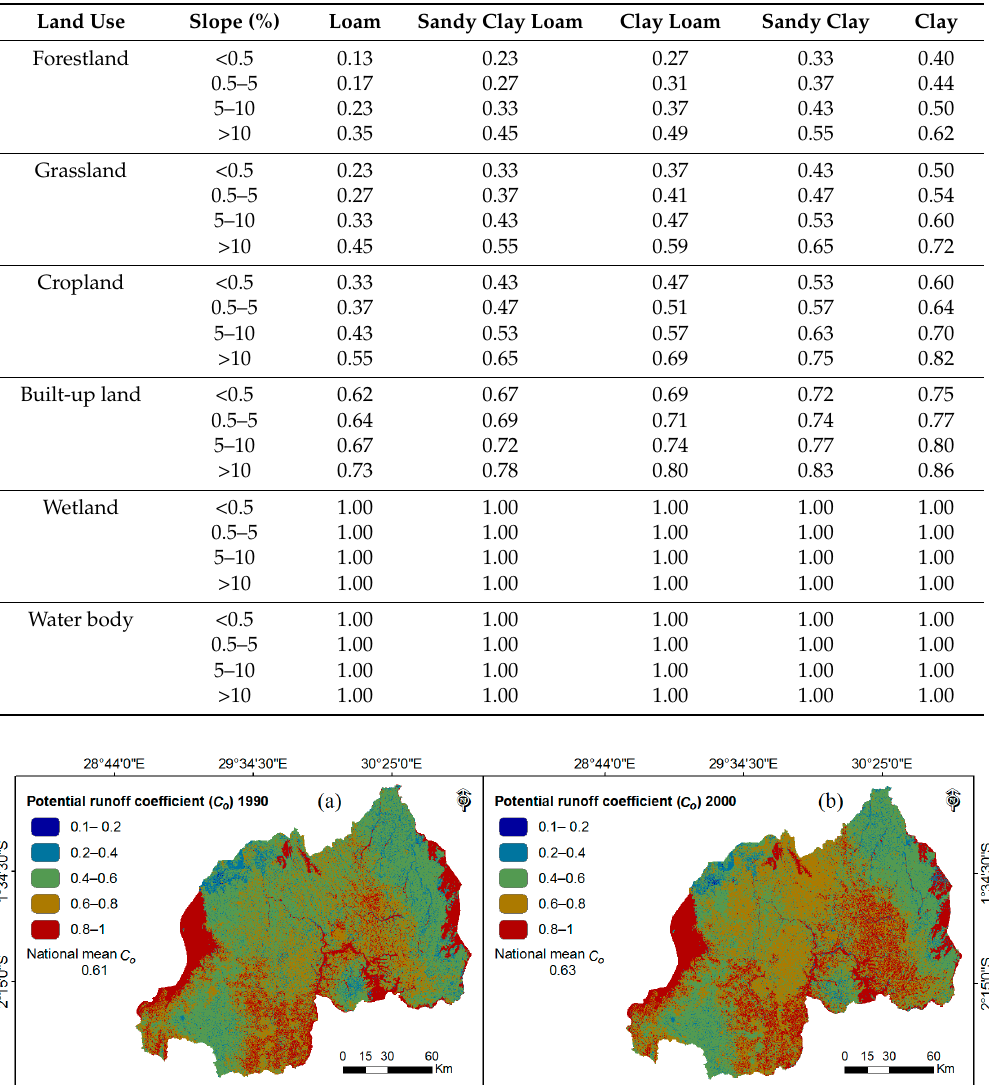
Table 1. The potential runoff coefficient for different land use, soil type and slope. Land Use Slope (%)